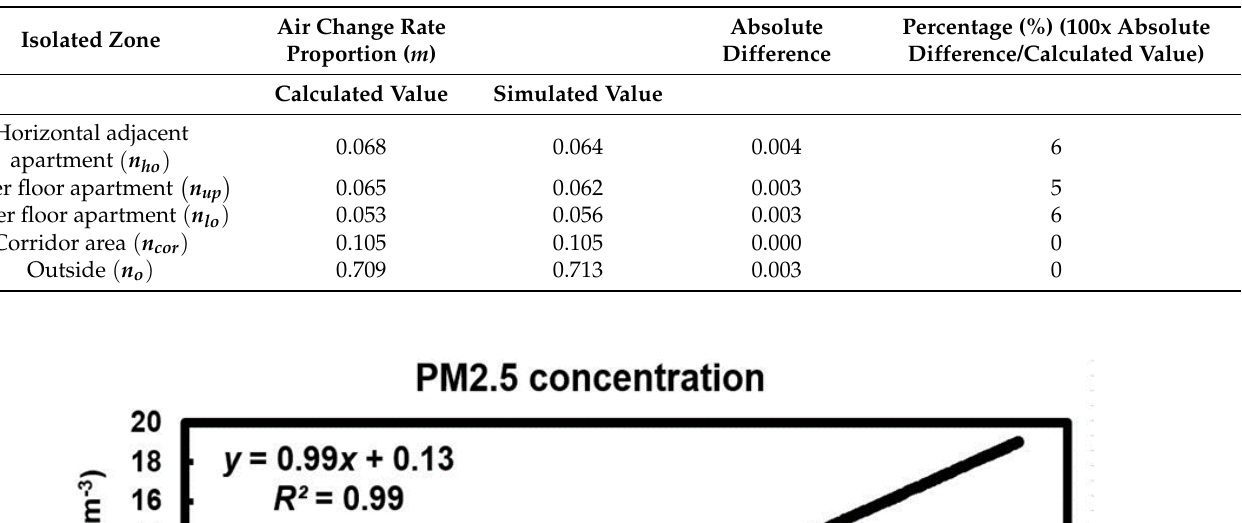
Table 5. Air change rate proportion of four adjacent areas and outside.